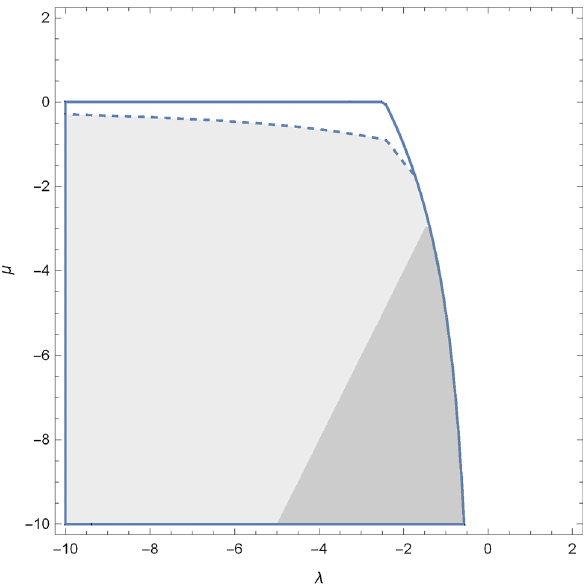
Fig. 1 Region plot in the space of variables { λ,μ } for the eigenvalues e 1 ( P C ) , e 2 ( P C ) . With the solid line is the boundary where the points exist. Dashed line describe the boundary where the points are attractors. The ope gray area corresponds to the case where w tot > − 1 the dark gray area describe the values of the parameters { λ,μ } in which w < − 1 tot